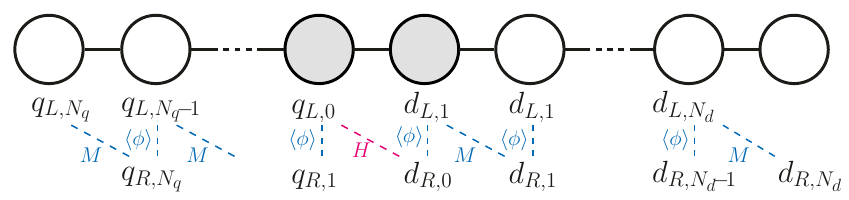
Figure 3 . The anomaly free inverted Froggatt-Nielsen model for a single generation of down quarks, but with rearranged (cid:12)elds on the nodes, see text for details.